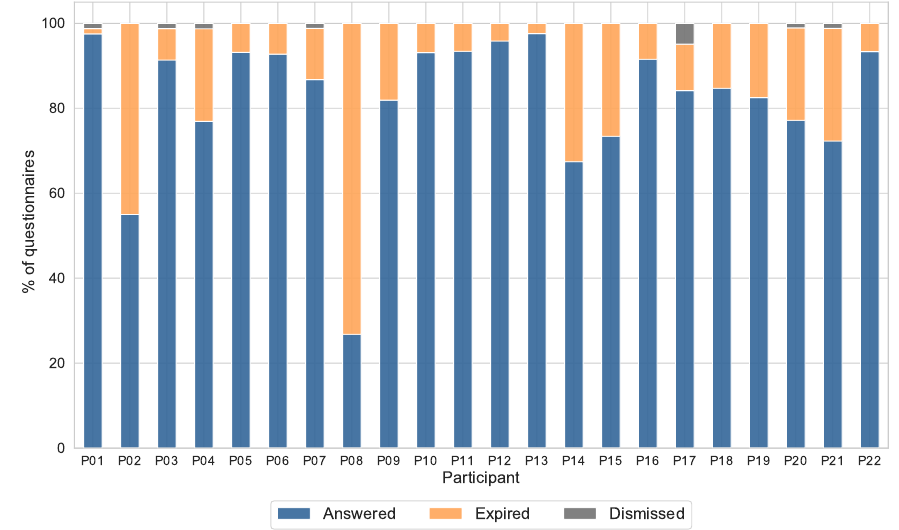
Figure 6. Percentage of questionnaires answered (blue), expired (orange) and actively dismissed (grey) for each participant during the entire